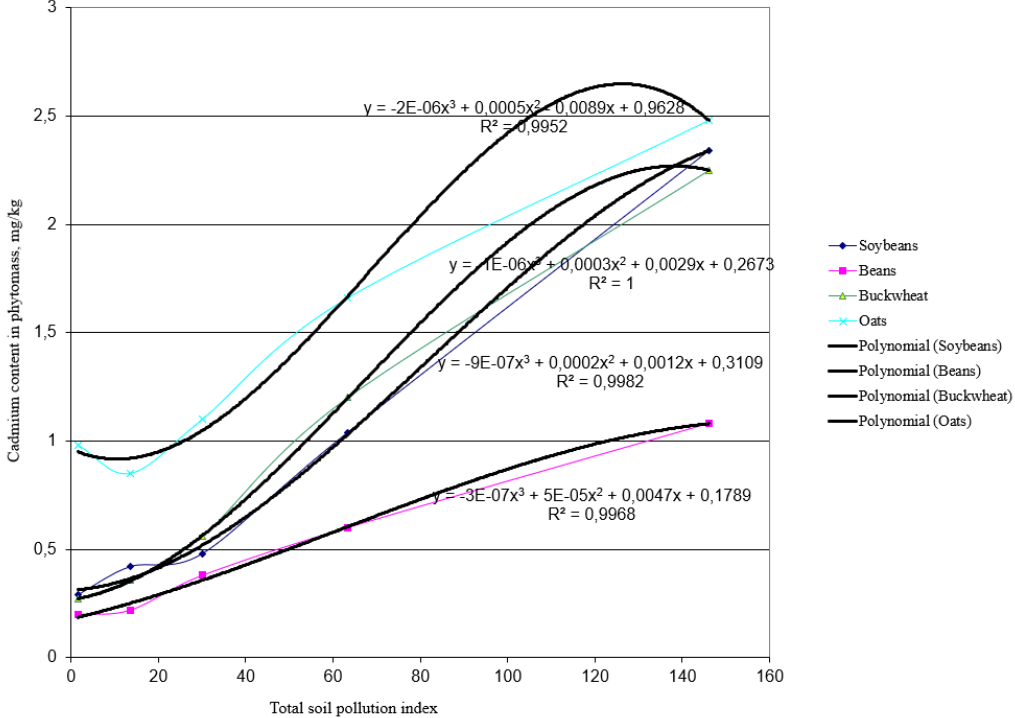
Figure 8. Dependence of cadmium content in plant phytomass on the level of soil pollution. For